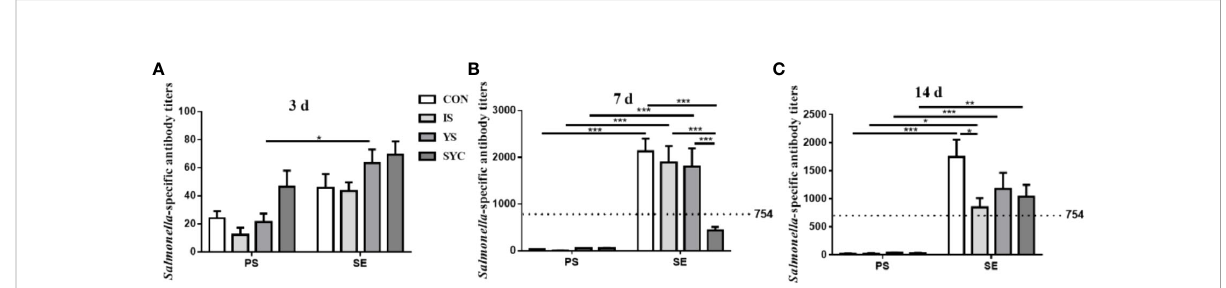
FIGURE 3 Effects of dietary supplementation with different Se sources on serum Salmonella -speci fi c antibody titers of layers challenged with S. Enteritidis . CON, basal diet; IS, sodium selenite; YS, yeast selenium; SYC, selenium-enriched yeast culture; PS, challenged with physiological saline solution; SE, challenged with S. Enteritidis . The titers were measured among different periods and treatments (A – C) . When the antibody titer was >754, the immune status of Salmonella is positive, and when the antibody titer was ≤ 754, the immune status of Salmonella is negative. The data were presented as mean ± SEM. Signi fi cance was compared with every other group; * P < 0.05, ** P < 0.01", *** P <